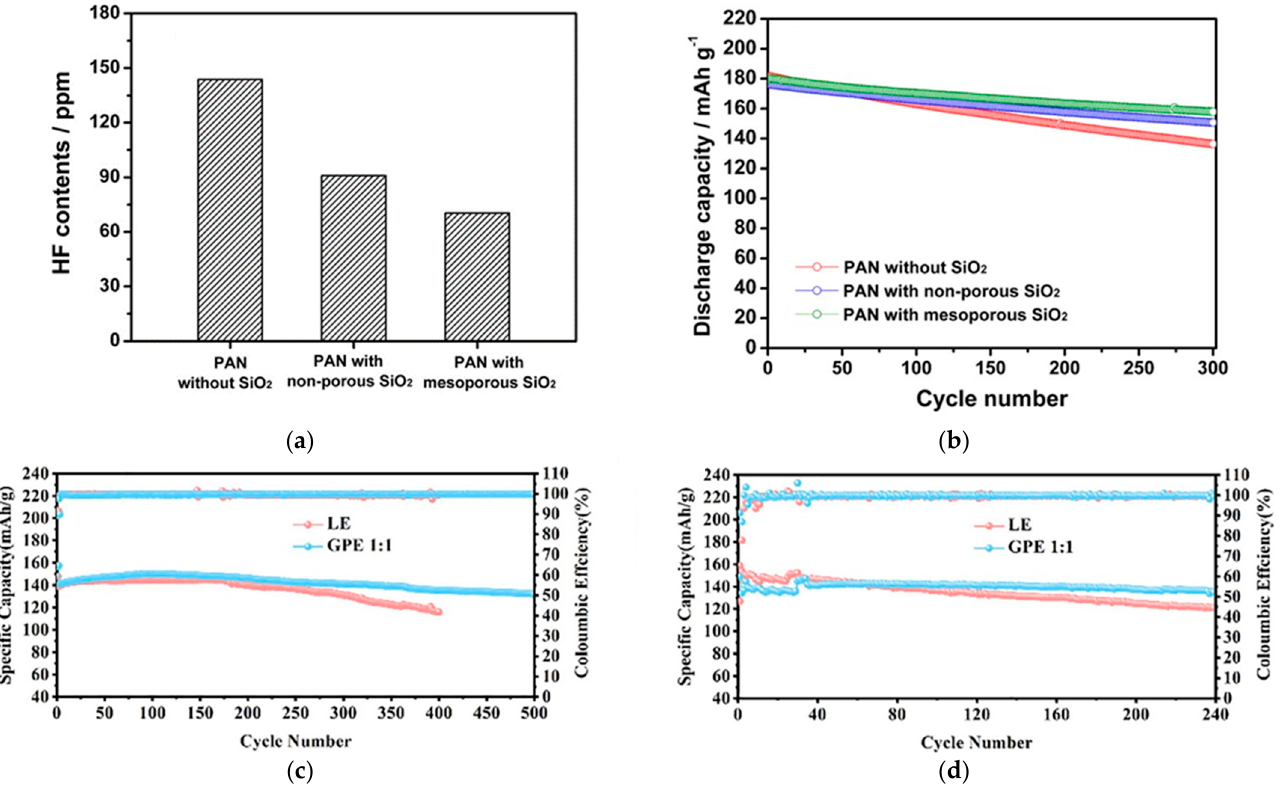
Figure 5. ( a ) HF content in the different electrolytes after being stored at 55 °C for 3 days; ( b ) Discharge capacities of lithium-ion polymer cells assembled with different electrolytes at 25 °C. Reprinted/adapted with permission from Ref. [94]. Copyright ®® 2016, Nature Publishing Group; ( c ) Cycling performances of LiFePO 4 |LE|Li cell and LiFePO4|GPE 1:1|Li cell with the LiFePO 4 loading of 1.5 mg cm − 2 and ( d ) mass loading 3 mg cm − 2 . Reprinted/adapted with permission from Ref. [88]. Copyright ®® 2022, Elsevier B. V.